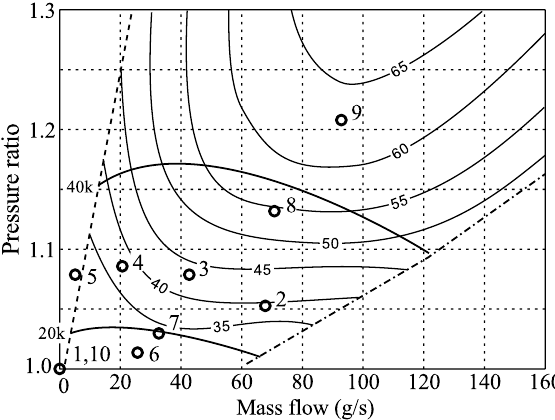
Figure 5. Rotrex C30-74 compressor map as provided by manufacturer with the tested points shown as ( ◦